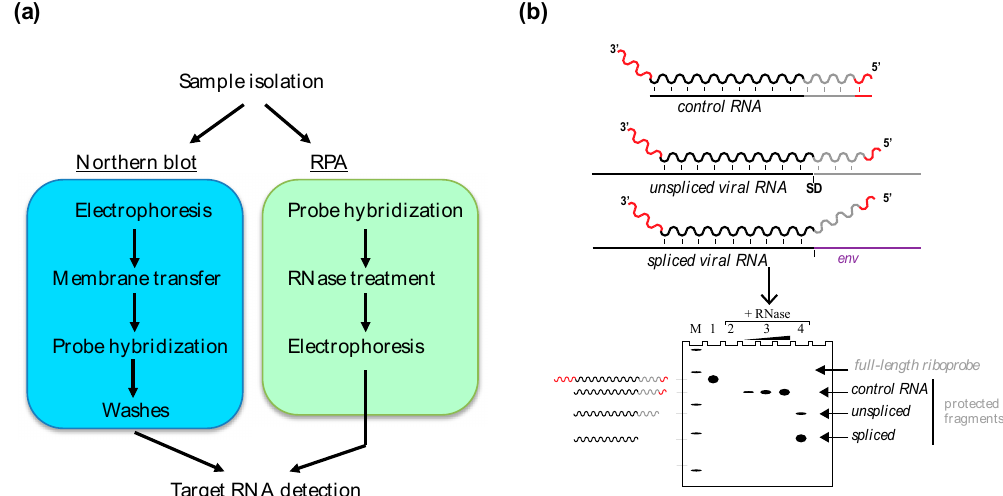
Figure 1. Gel ‐ based detection of RNA. ( a ) Comparison of the experimental workflow in Northern blot (left) and ribonuclease protection assay (RPA) (right). Several steps are common to both techniques, including probe labeling, hybridization and electrophoresis. ( b ) Schematic representation of probe annealing during RPA. A synthetic probe is composed of sequences present (black and gray) or absent (red) from the target RNA. The drawing represents probe annealing to a control RNA produced in vitro and to the products of splicing in a simple retrovirus. SD, splice donor site; env , envelope gene. Annealing (vertical lines) protects from RNase treatment, generating double ‐ stranded fragments, which are visualized after gel electrophoresis (Lanes: M, size marker; 1, untreated probe; 2, probe only; 3, probe with increasing concentration of control RNA; 4, probe with sample containing retroviral RNA).